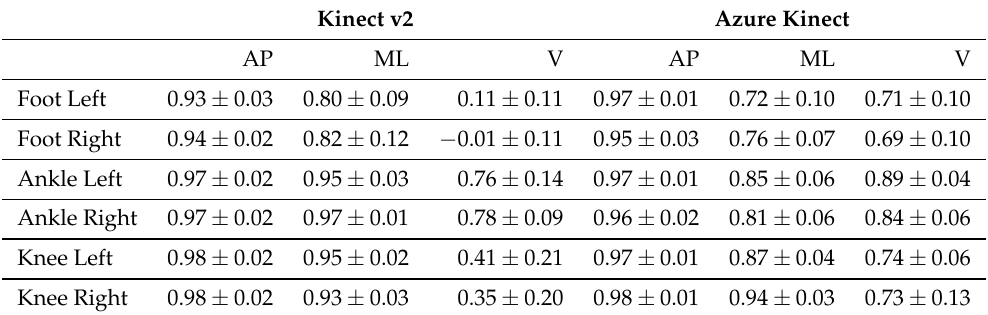
Table 3. Pearson’s correlation coefficient r in the AP, ML, and V direction. The last three joints are only present in the Azure Kinect skeleton definition and thus marked as not present (n.p.) for Kinect